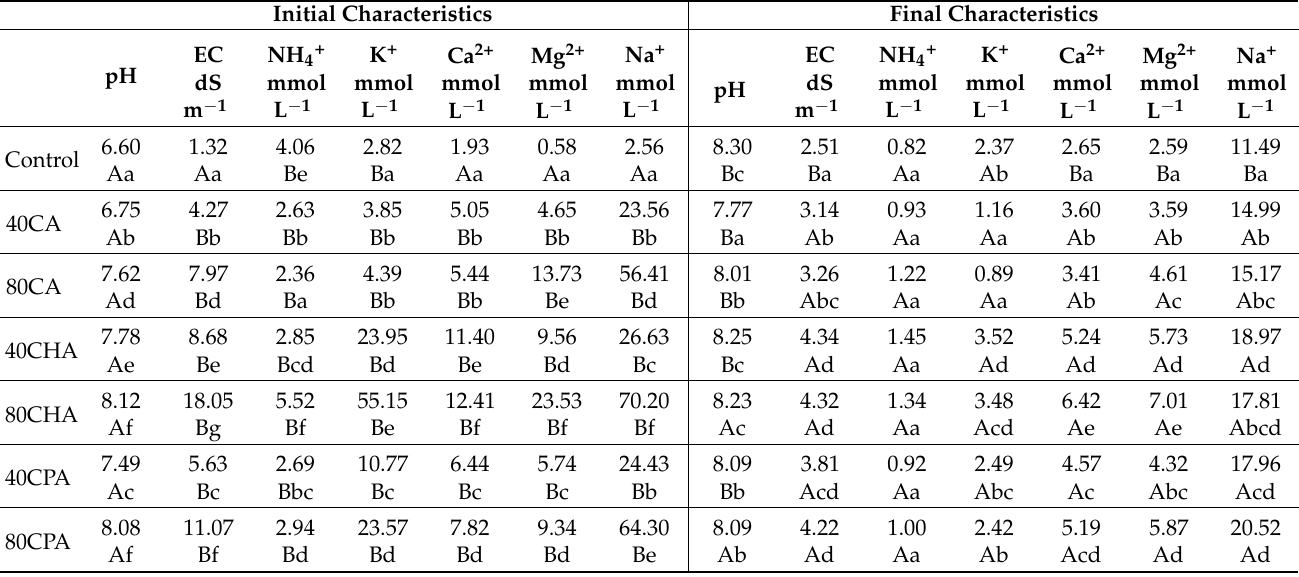
Table 3. Effects of different treatments on the initial and final pH, electrical conductivity (EC), and cation concentrations in paste saturated extracts of the substrates (NH 4+ ; K + ; Ca 2+ ; Mg 2+ ; Na +